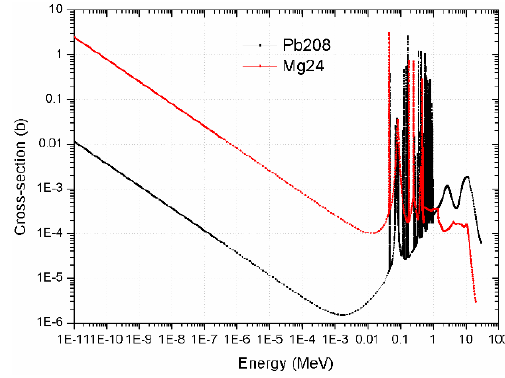
Figure 6. Capture scattering cross sections for the major isotopes of reflector material [17].